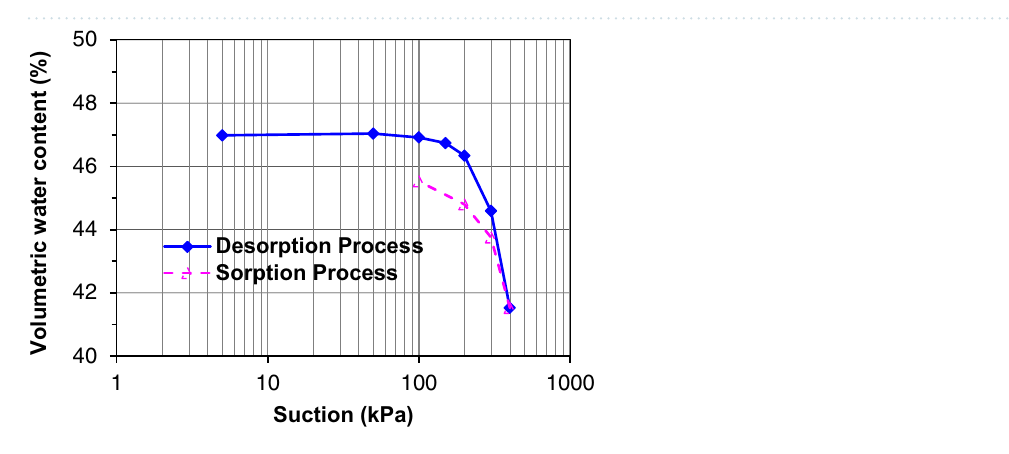
Figure 3. Soil–water characteristics curve.